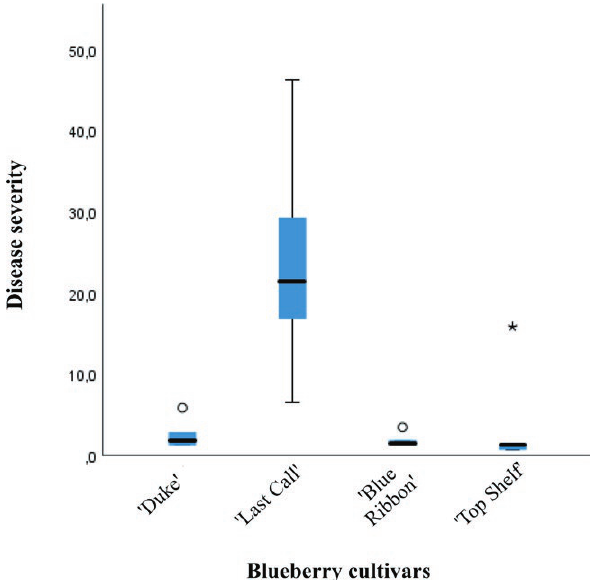
Figure 4. Box plot of results of pathogenicity tests on detached blueberry leaves. Boxes represent the interquartile range, and the horizontal line within each box indicates the average value. The Kruskal-Wallis test was used to compare the mean leaf areas infect- ed after inoculations of four cultivars, and significant differences were accepted at P <